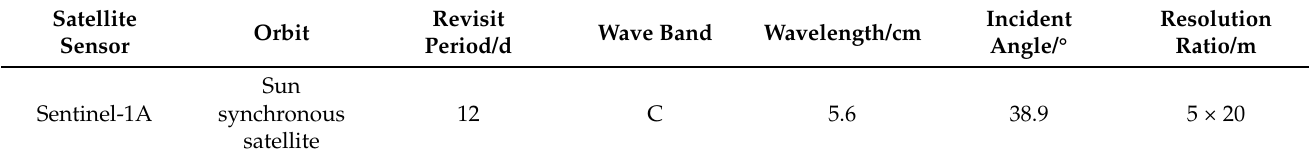
Table 1. Main parameters of satellite system.